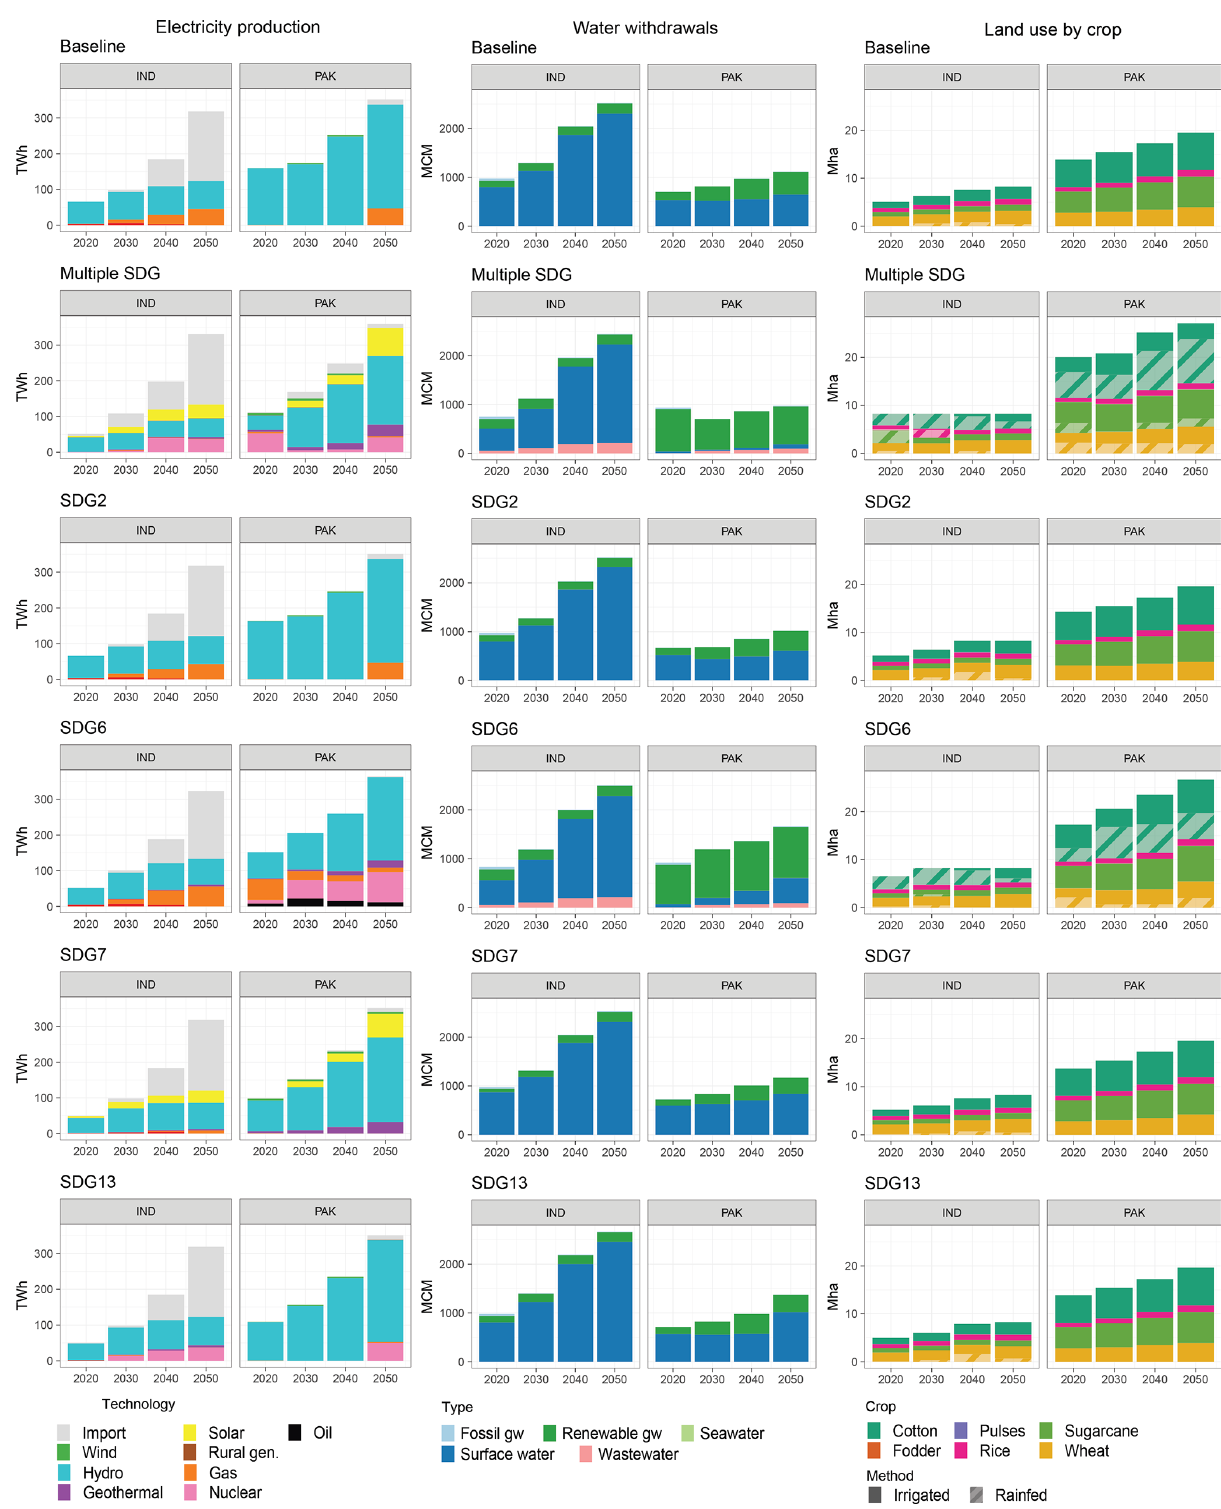
Figure 12. Comparison among different scenarios of yearly values for Pakistan (PAK) and part of India in the Indus basin (IND) of electricity supply mix (TWh), water withdrawals from different sources (MCM), total land used for farming different crops (Mha), distinguishing between irrigated (dark color) and non-irrigated areas